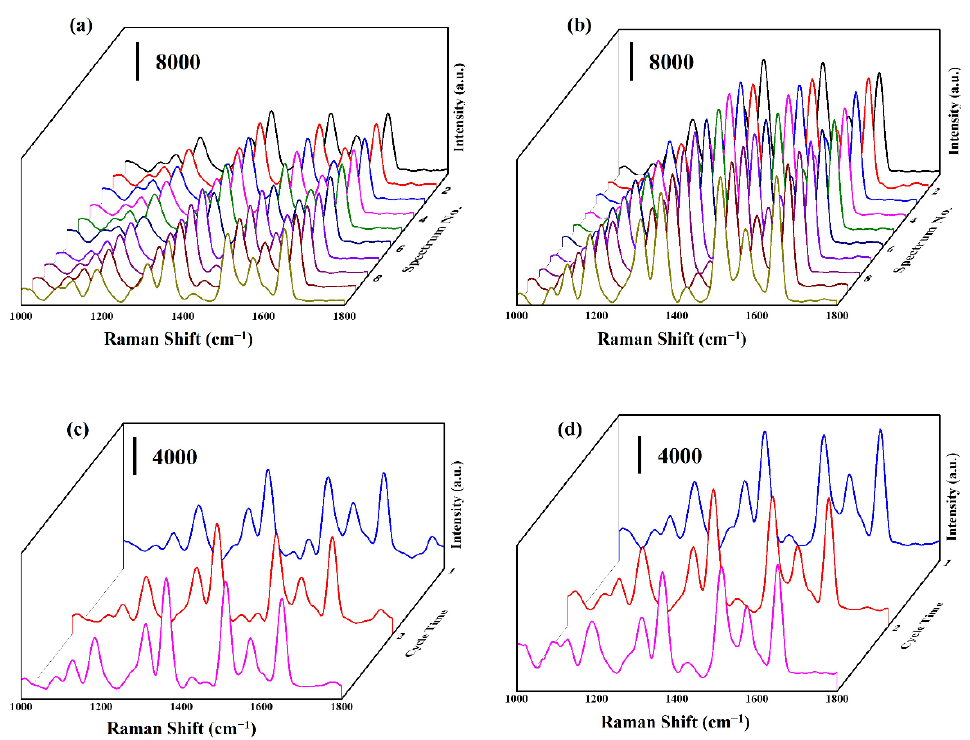
Figure 7. SERS spectra of R6G (10 − 6 M) at ten random points on ( a ) CuO@Ag nanowires and ( b ) CuO@RF@Ag nanowires. SERS spectra of R6G (10 − 7 M) on ( c ) CuO@Ag nanowires, and ( d ) CuO@RF@Ag nanowires at the three cycles for 1 cycle (blue line), 2 cycle (red line), and 3 cycle (purple).